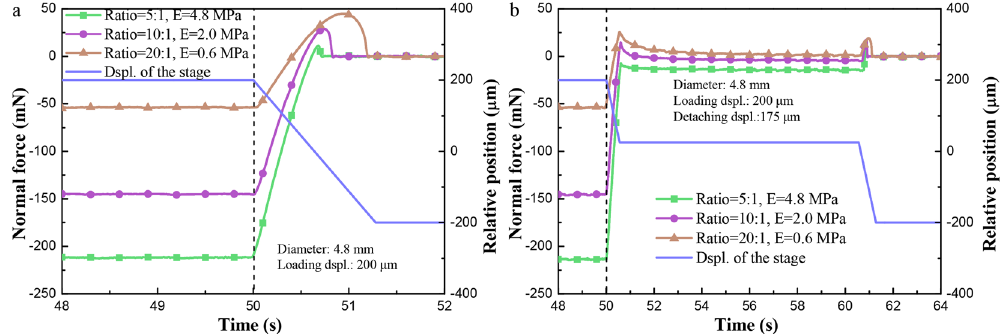
Figure 3. Force–time curves in OSD and TSD for PDMS sphere made of ratio 5:1, 10:1 and 20:1, respectively. ( a ) Curve in OSD, a loading displacement of 200 μ m with different PDMS ratios (diameter D = 4.8 mm, detaching velocity v = 313 μ m/s); ( b ) Curve in TSD, first detaching displacement of 175 μ m and a loading